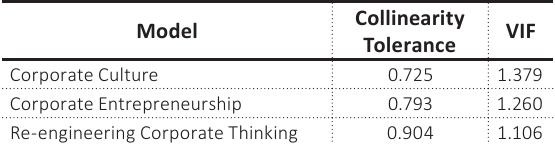
Table 3. Multicollinearity test